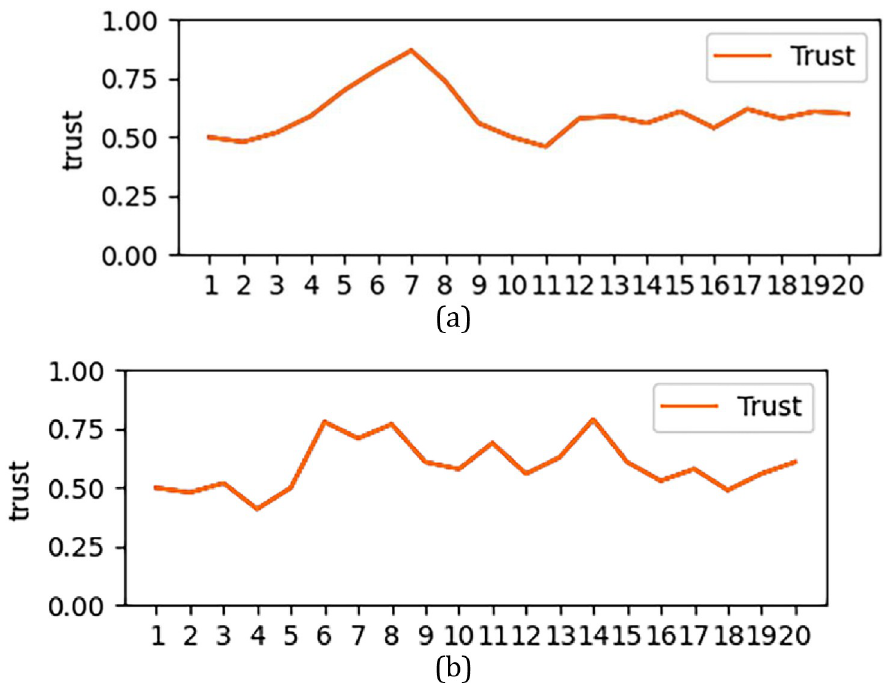
Fig 6. Comparison of trust status within a certain